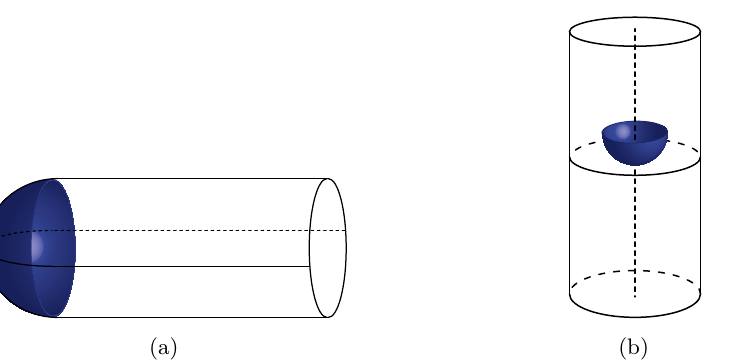
Figure 11 . Sine-Liouville Asymptotic Conditions . The spacetime image of the string worldsheet in the neighborhood of a W + insertion is shown in the cigar description of SL(2 , R ) k / U(1) (left) and the cylinder description of SL(2 , C ) k / SU(2)